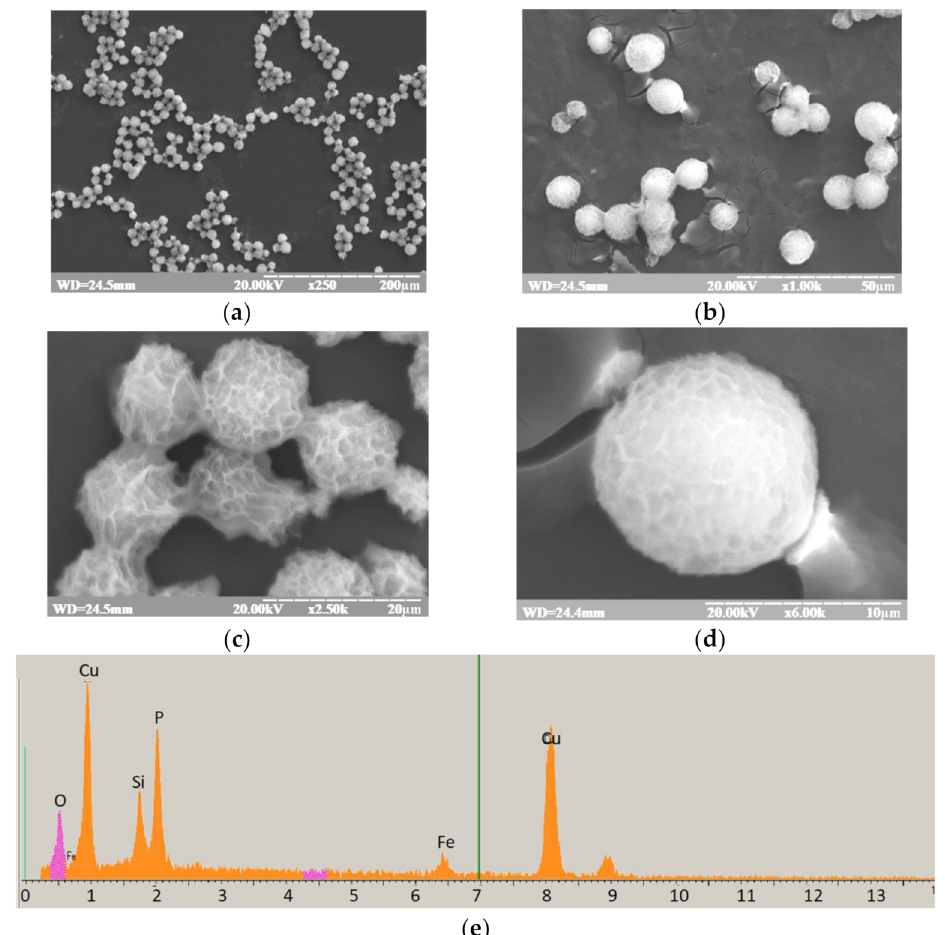
Figure 3. The results of gCuHCF study using SEM with RSM: ( a – d )—SEM images at different magnifications; ( e )—X-ray spectral